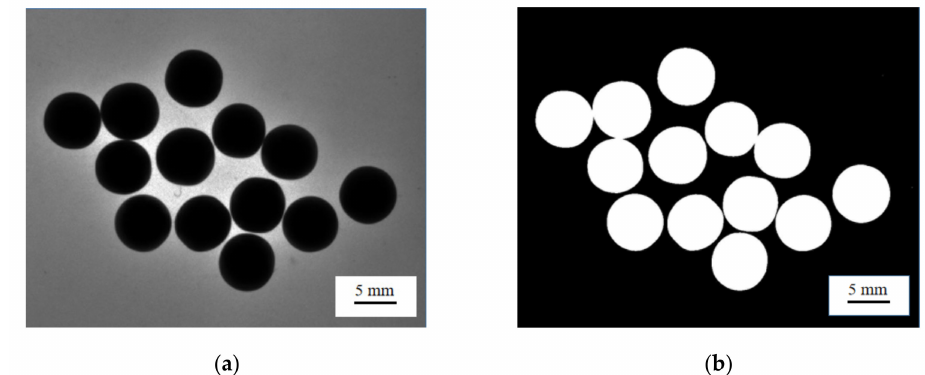
Figure 3. Pearl image preprocessing. ( a ) Original image of pearl; ( b ) pearl binary diagram.